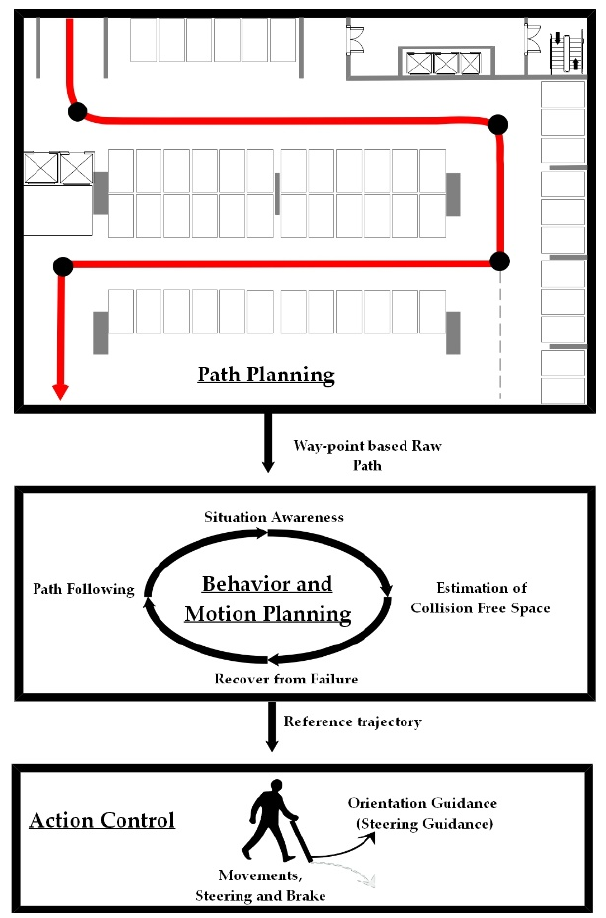
Figure 1. A three-layer planning-related decision-making structure for blind and visually impaired (BVI) navigation systems. (BVI) navigation